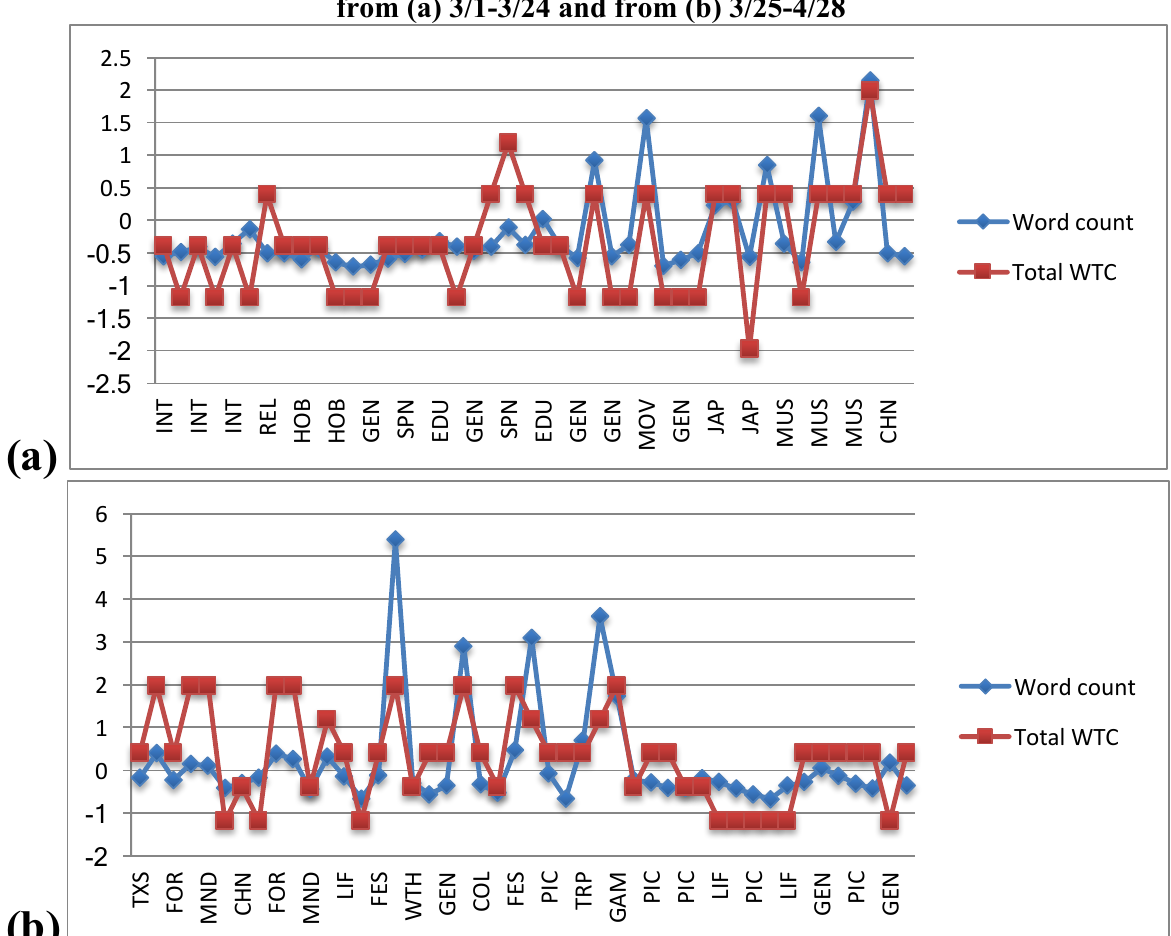
Topic evolution by standardized word count and WTC